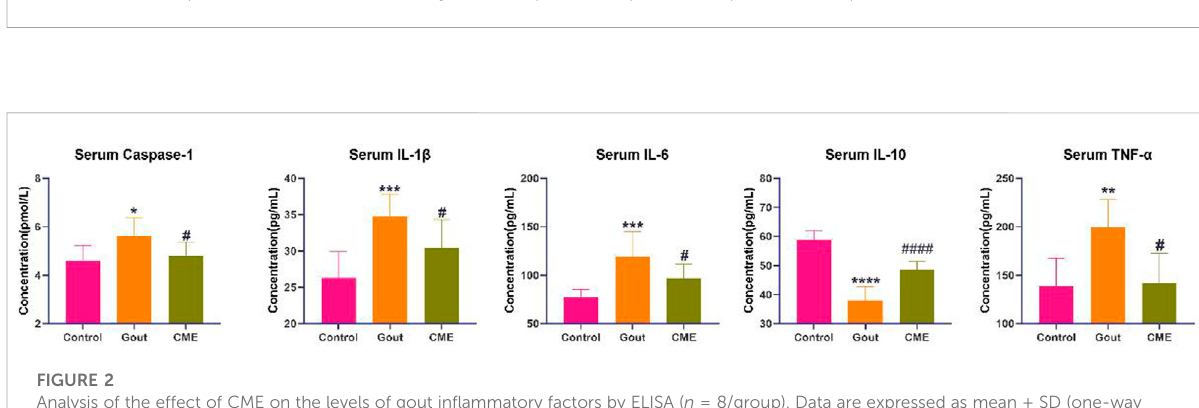
the ankle joint. ELISA analysis (Figure 2) showed that the gout group signi fi cantly up-regulated the levels of IL-1 β , Caspase-1, IL-6 and TNF- α , and signi fi cantly decreased the levels of IL-10, which were induced by MSU ( p < 0.05). Compared with the gout group, the CME-high group signi fi cantly modulated the levels of these in fl ammatory factors ( p < 0.05).